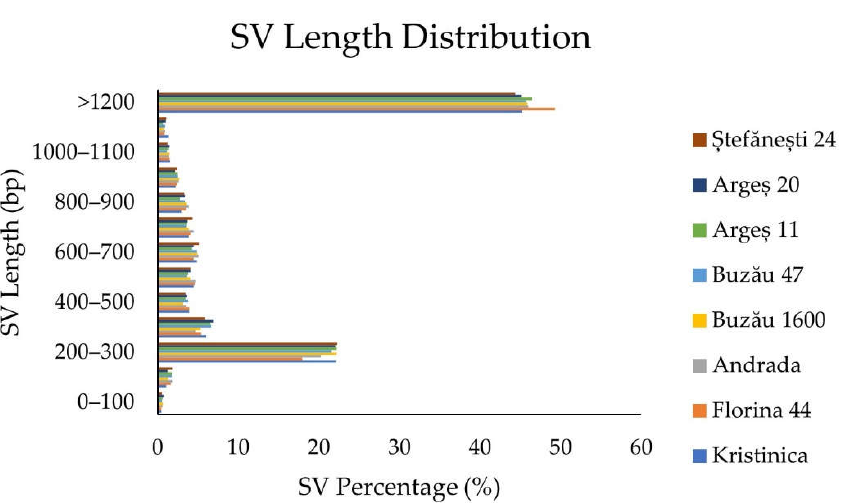
Figure 5. SV distribution within genotypes studied. CTX—interchromosomal translocation, DEL— deletion, INS—insertion, INV—inversion, ITX—intrachromosomal translocation. The highest percentage of SVs was interchromosomal translocations, followed by the deletions, intrachromosomal translocations, inversions, and insertions. More than 40% of SVs were longer than 1200 bp. Approximately 20% of the SVs had a length of 200–300 bp. For the rest of the SVs’ length-size categories, the percentages were lower than 7%. The rarest SVs were those with a length of less than 100 bp (~0.4–0.7%) (Figure 6).